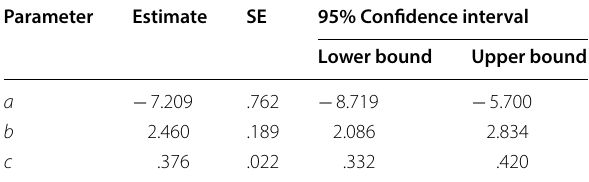
Table 14 Parameter